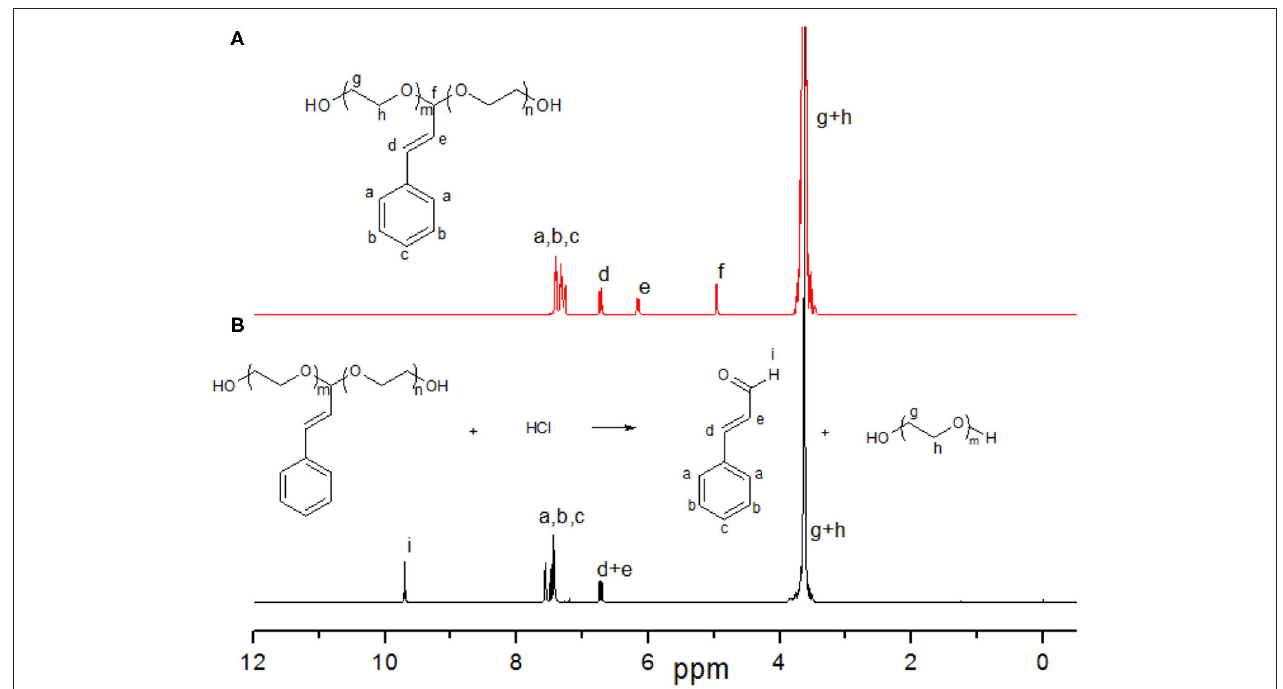
FIGURE 3 | 1 H NMR spectra of HO-PEG(ca)-OH (A) and its degradable residue in acid (B) in CDCl 3 .